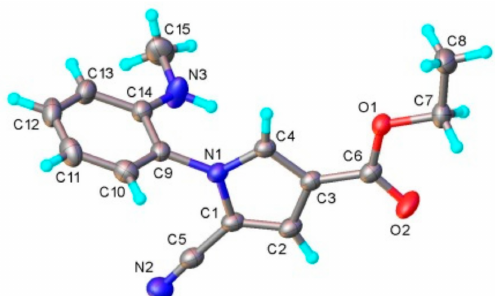
Figure 4. X-ray molecular structure of 17c with atom labeling and thermal ellipsoids at the 50%